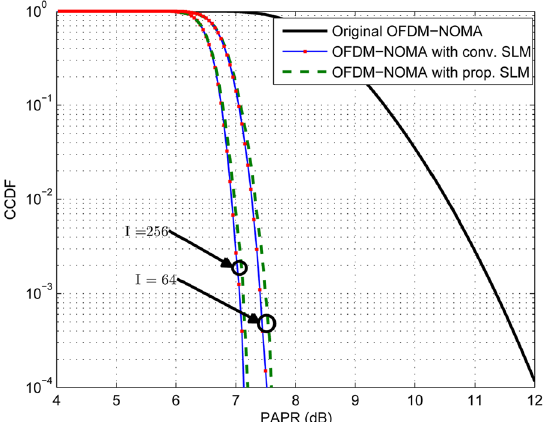
Fig. 5 PAPR reduction performance of conventional and proposed SLM techniques with different number of alternatives, i.e., I =